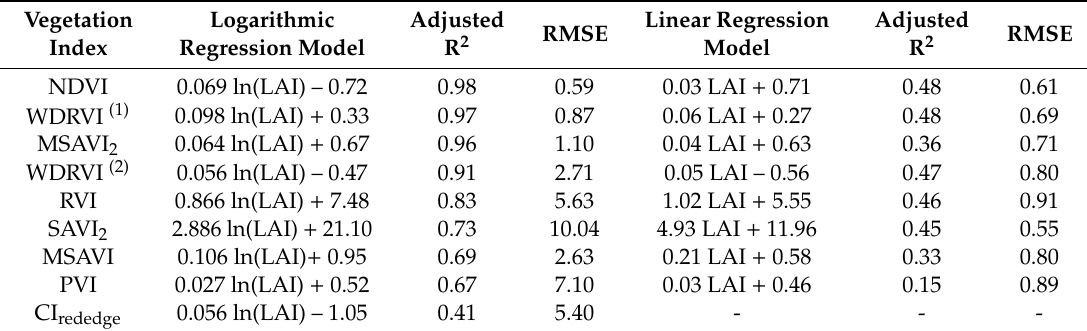
Table 2. Logarithmic and linear (with no-leaf values excluded) regression functions and their